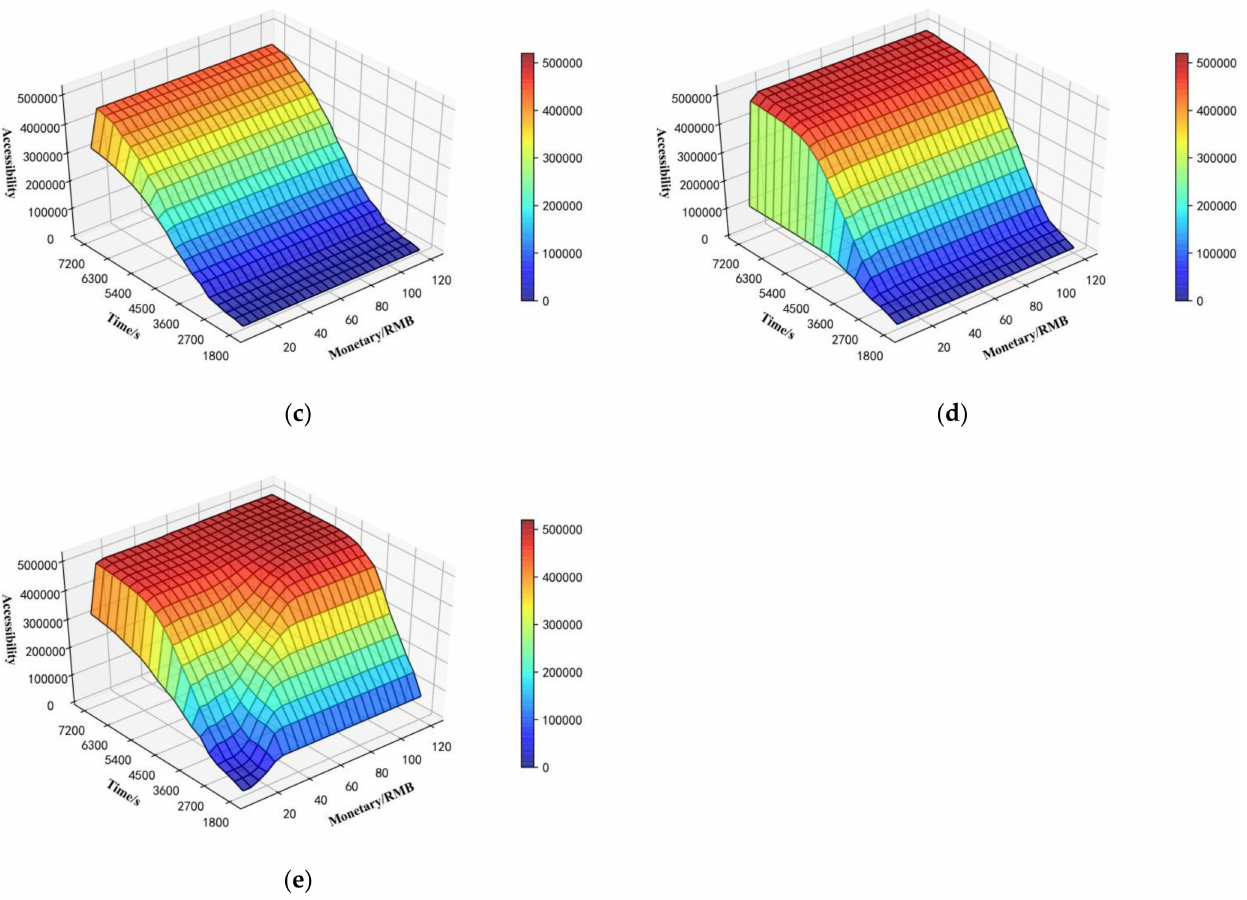
Figure 9. Accessibility of various modes in the central area: ( a ) taxi accessibility, ( b ) bus accessibility, ( c ) subway accessibility, ( d ) combined-mode accessibility, and ( e ) multimodal accessibility.